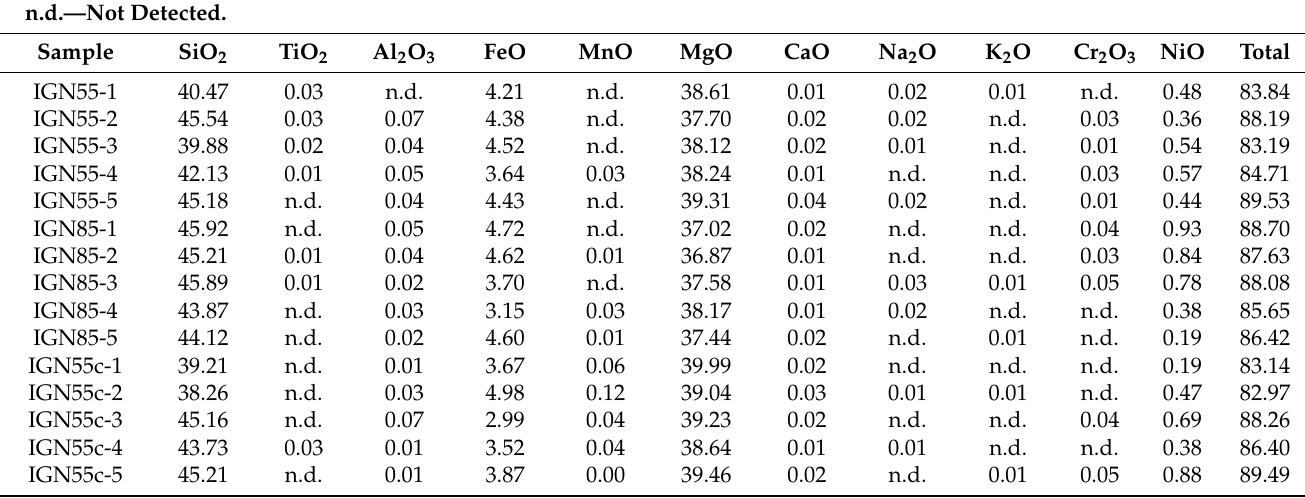
Table 2. Representative analyses of serpentine (wt%) in the high-Cr chromitite of Sebuku Island. n.d.—Not Detected.